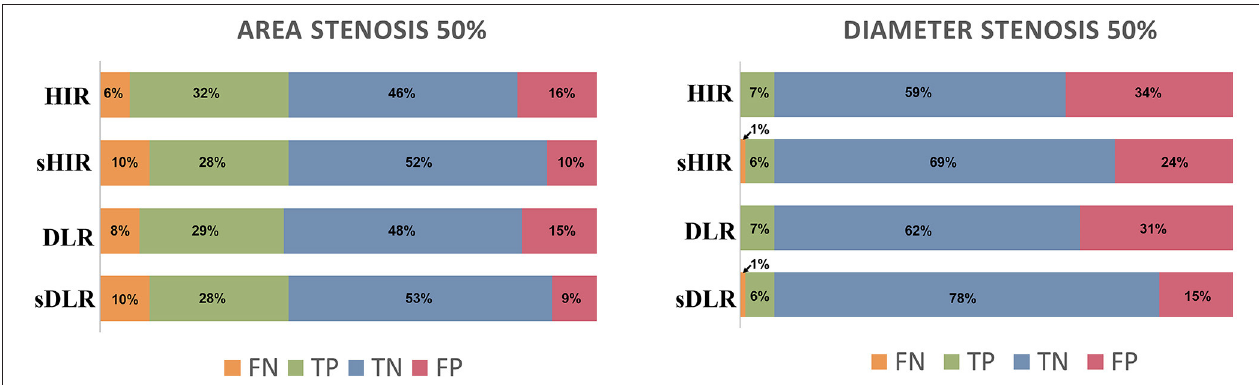
FIGURE 4 | Stenosis evaluation. The false positive rates of CTA sDLR and CTA sHIR for luminal area stenosis ≥ 50% were 9 and 10%, respectively, while the corresponding values for luminal diameter stenosis ≥ 50% were 15 and 24%. DLR, deep learning–based image reconstruction; HIR, iterative reconstruction; sDLR, subtraction deep learning–based image reconstruction; sHIR, subtraction iterative reconstruction; TP, true positive; FP, false positive; TN, true negative; FN, false